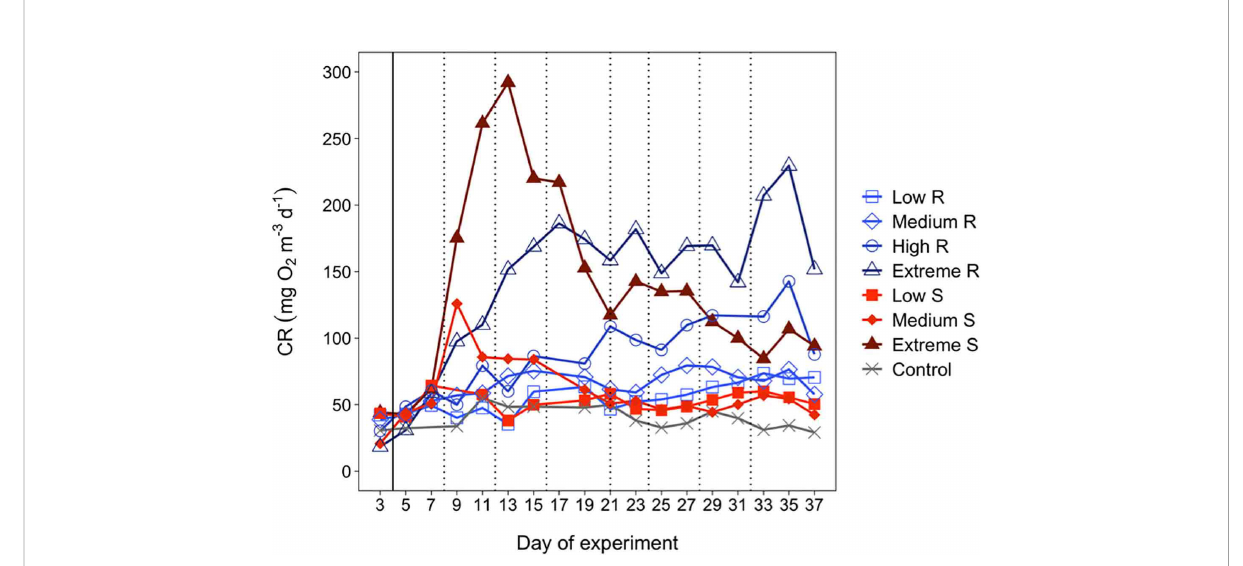
FIGURE 2 Temporal development of plankton community respiration (CR). The solid black line indicates the fi rst deep-water addition (except in the control). The dotted black lines indicate the addition made only to the recurring